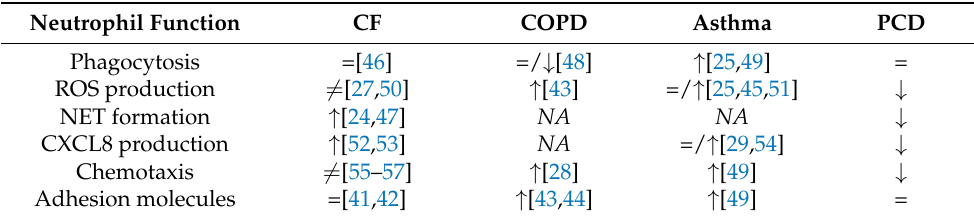
Table 2. Overview of peripheral blood neutrophil dysfunction in common chronic neutrophil- dominated lung